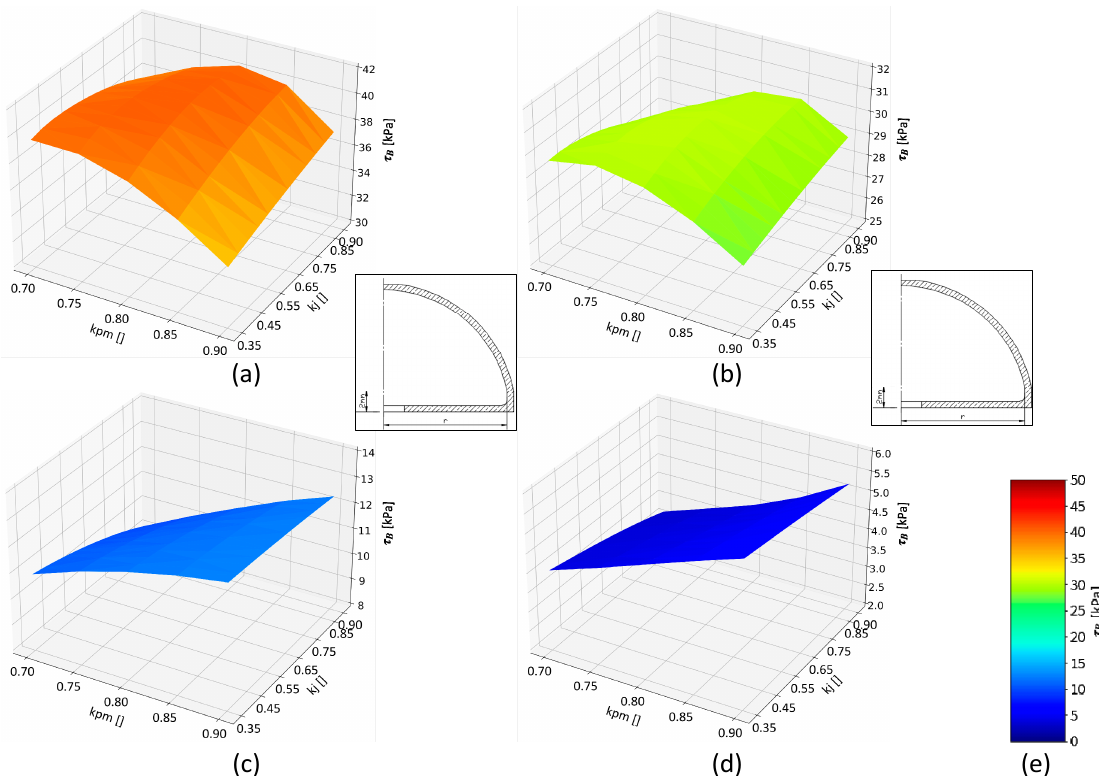
Figure 13. Average values of shear stress τ B along the measurement section of the MR cushion cross section ( Instance 1 ) for all configurations kpm / kj . Analysis was performed for the value gm = 6 mm and the magnetic field exciter distance z equal to: ( a ) 0 mm; ( b ) 1 mm; ( c ) 5 mm; ( d ) 10 mm; ( e ) color scale indicating shear stress value.